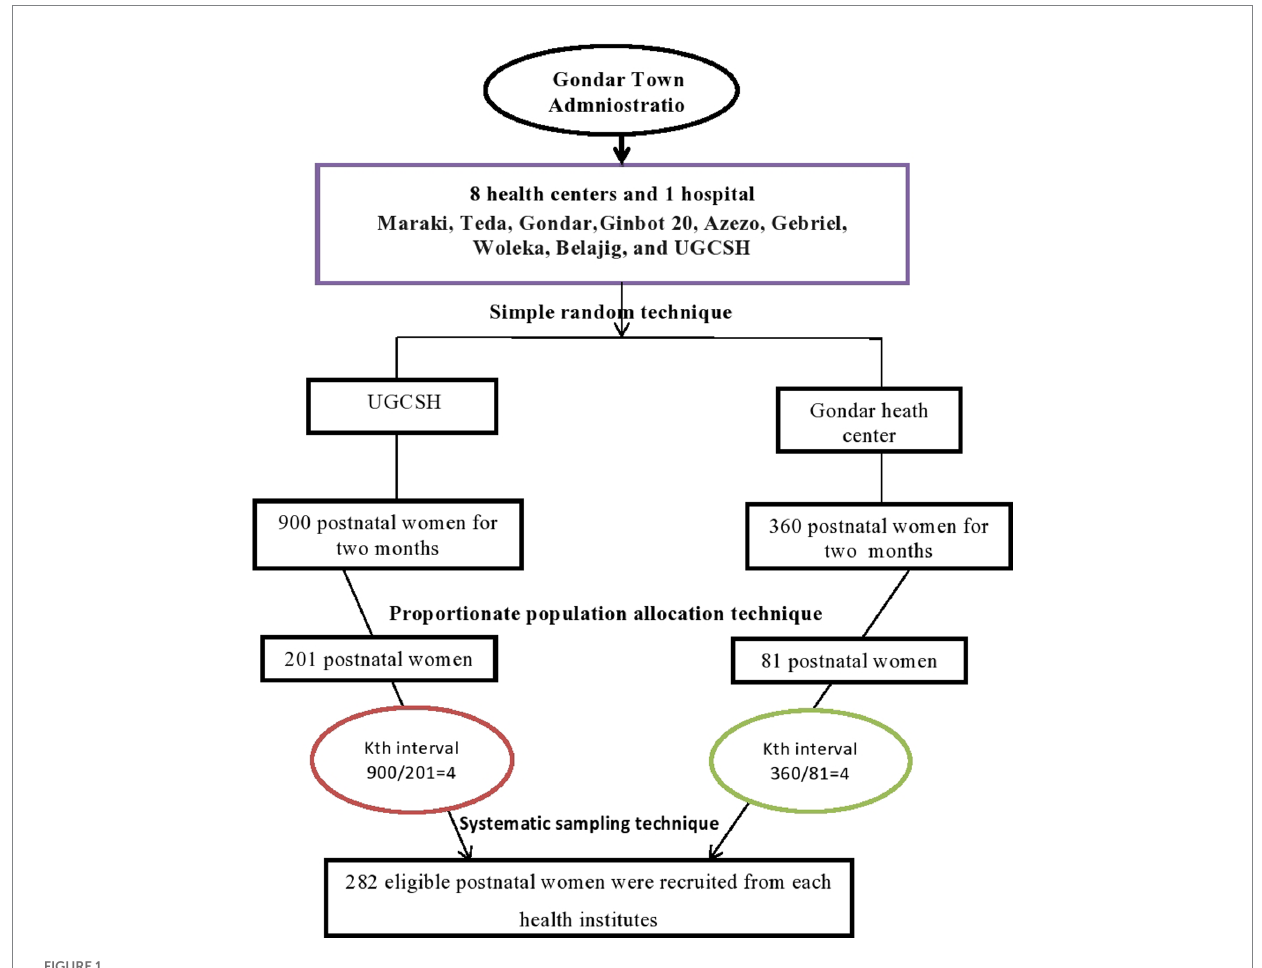
FIGURE 1 Schematic presentation of sampling